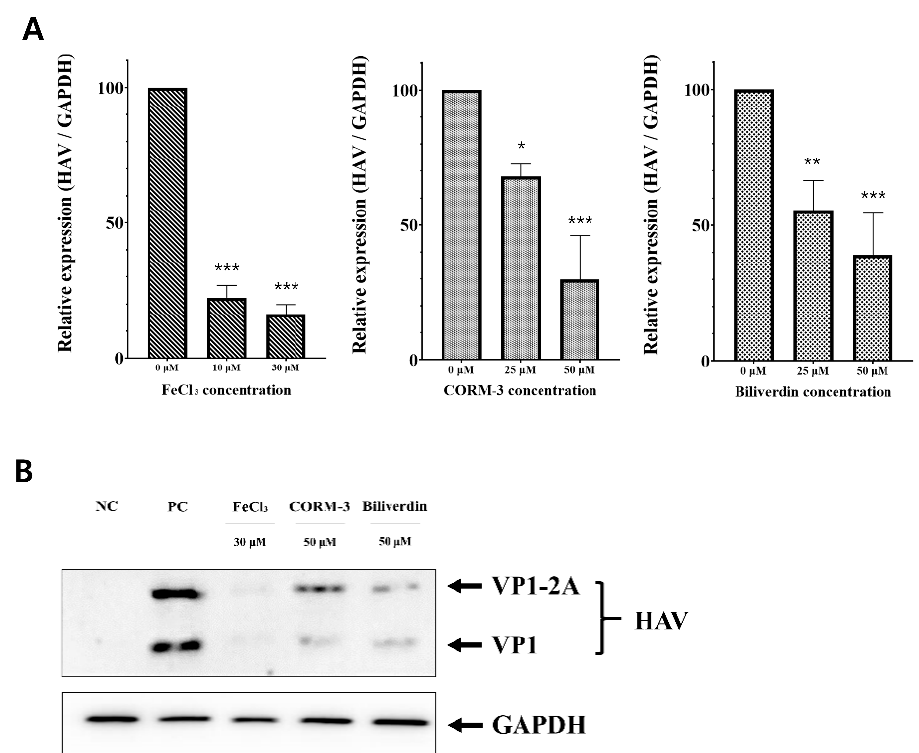
3.4. Suppression of HAV Replication by Metabolites of Heme Produced through HO-1 Catalysis HO-1 catalyzes the generation of CO, ferrous ion, and biliverdin from heme. We eval- uated the inhibitory effect of these three metabolites on HAV proliferation. FRhK-4 cells were infected with HAV and simultaneously treated with FeCl 3 , CORM-3, and biliverdin. All three metabolites of heme suppressed the replication of the viral RNA without cytotoxi- city (Figure 4A and Figure S2). On the basis of the qPCR results, Western blot assay was conducted using the highest concentrations of FeCl 3 , CORM-3, and biliverdin used in a previous experiment three days after infection. Expression of the VP1 protein of HAV was decreased by the treatment of the three metabolites, consistent with the reduced replication of the viral RNA (Figure 4B). Through these results, we confirmed that the breakdown of heme into CO, ferrous ion, and biliverdin could suppress HAV replication.